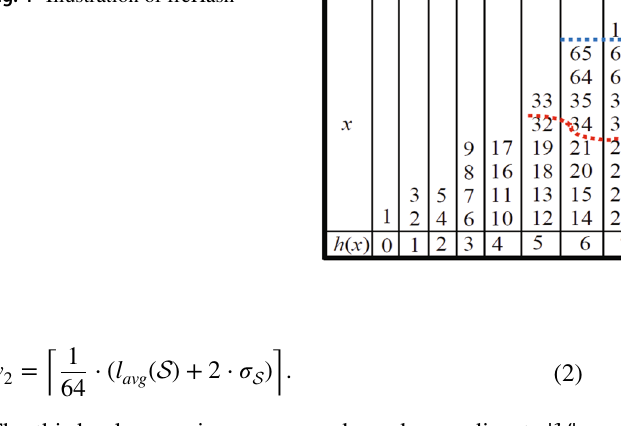
Fig. 4 Illustration of